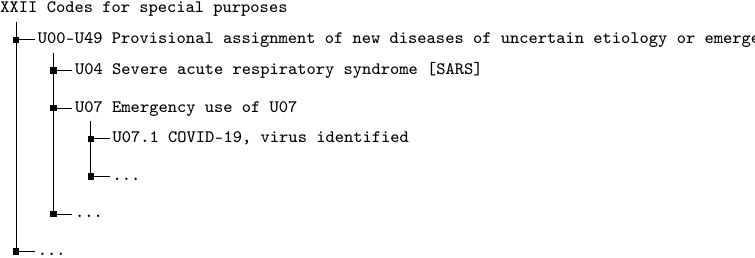
Figure 3. Example structure of chapter 22 of